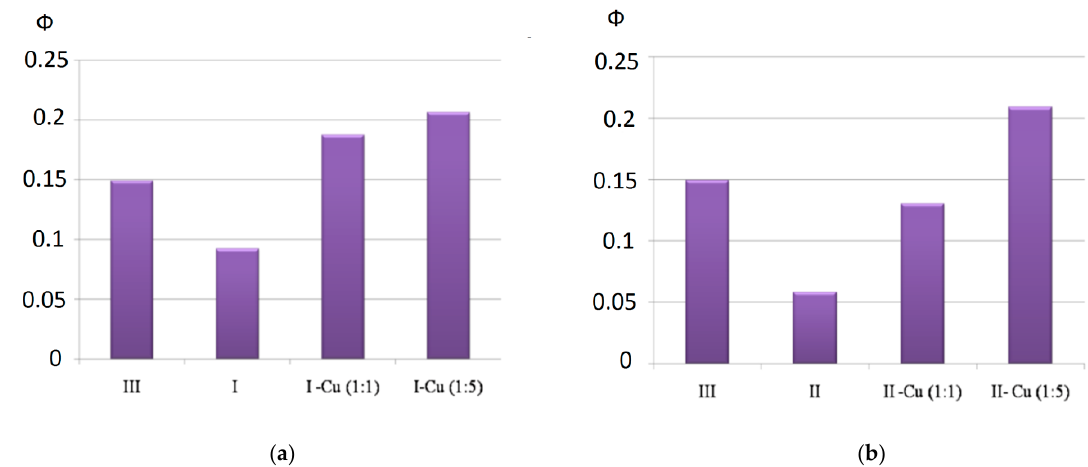
Figure 13. ( a ) Fluorescence quantum yields of complexes III and I and products of their interaction with Cu 2+ depending